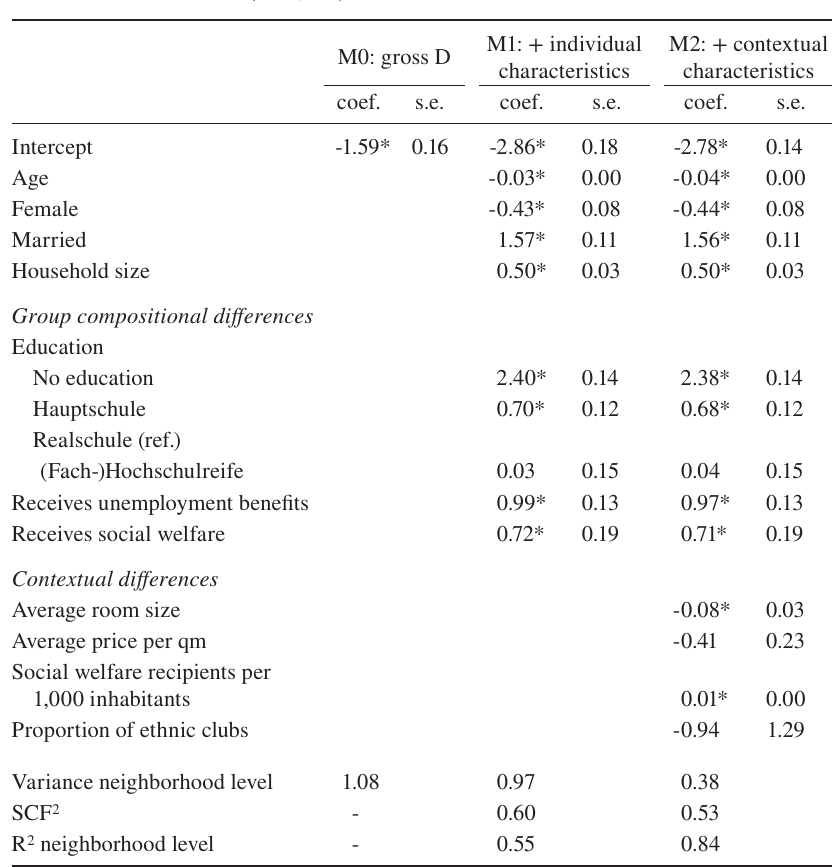
Multilevel modelling of ethnic residential segregation in Duisburg, 2003-2006